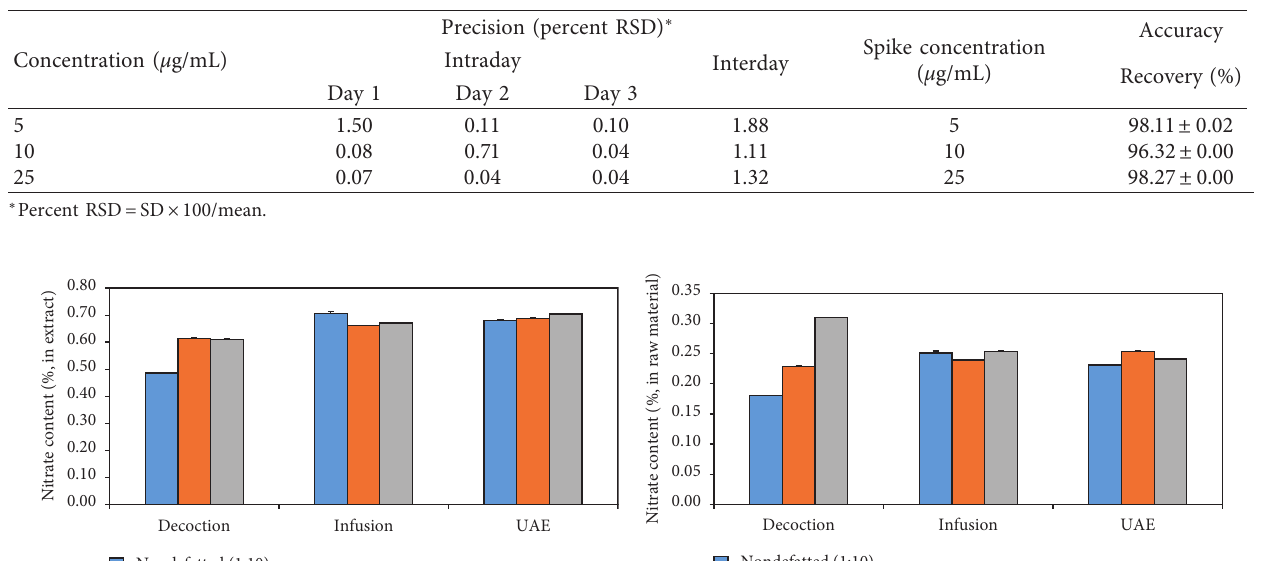
Figure 3: UV spectrums of (a) standard nitrate and nitrate in the C. anisata extract at (b) upslope, (c) top, and (d) downslope of the Table 1: Precision and accuracy of nitrate analysis.